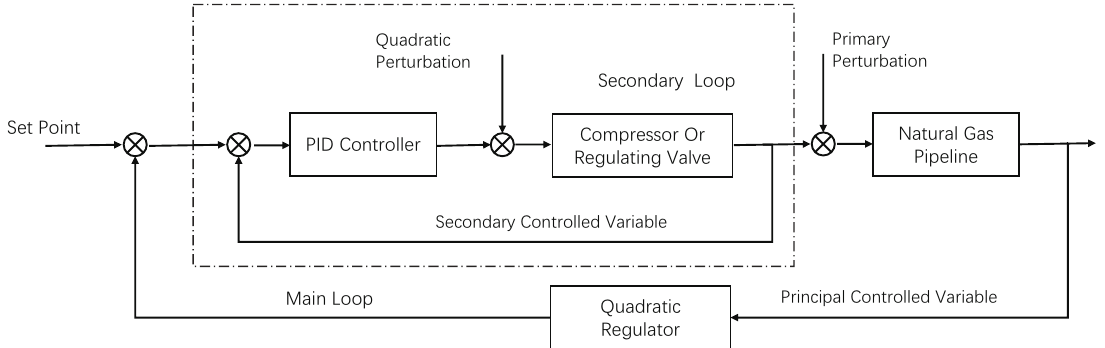
Figure 2. The cascade control system of the natural gas